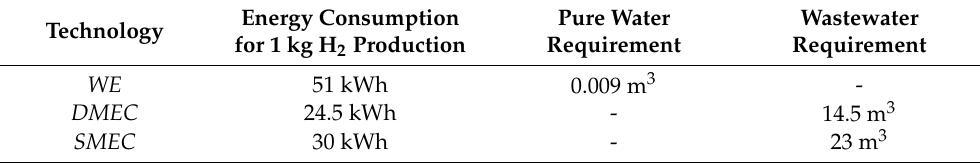
Table 3. One kilogram of hydrogen production in both types of MECs compared to